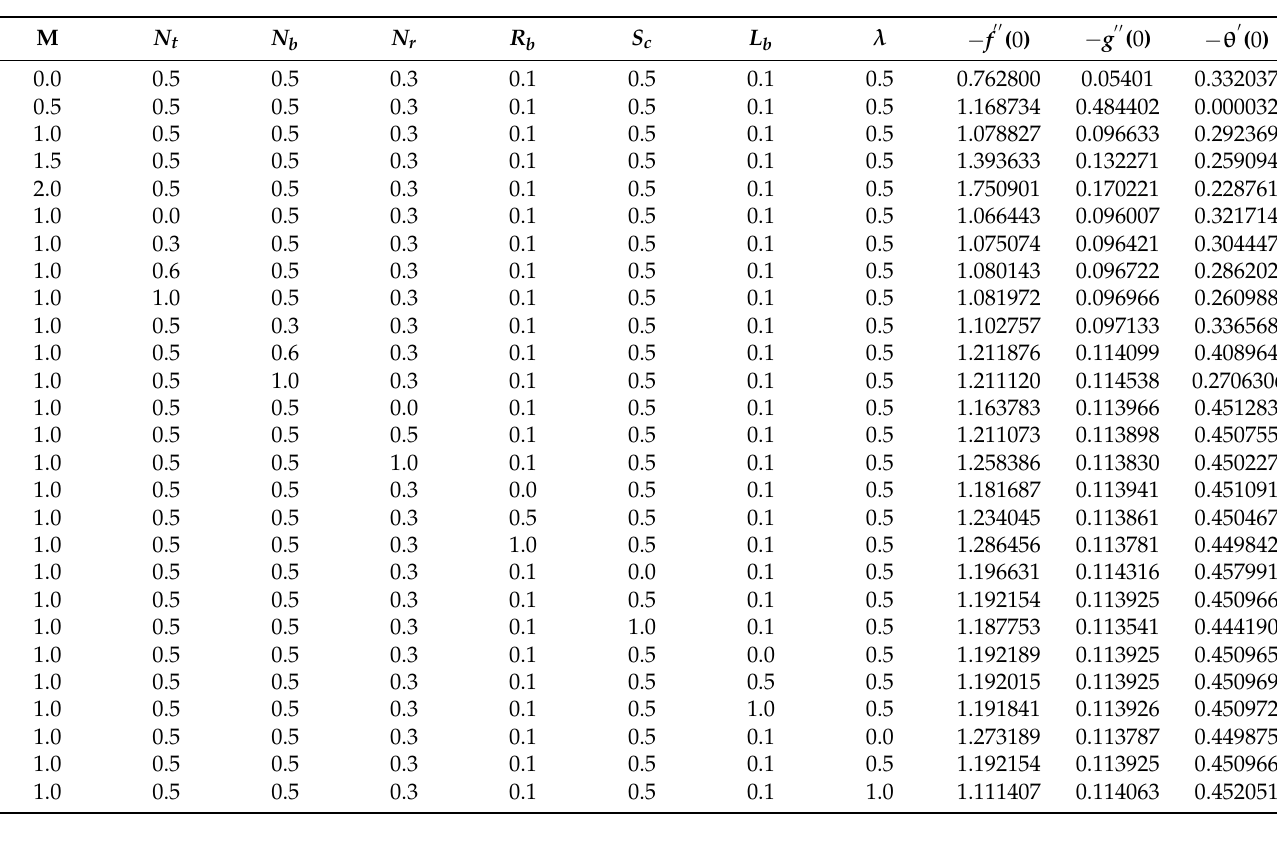
Table 1. Skin friction coefficient values and Nusselt number against significant parameters.